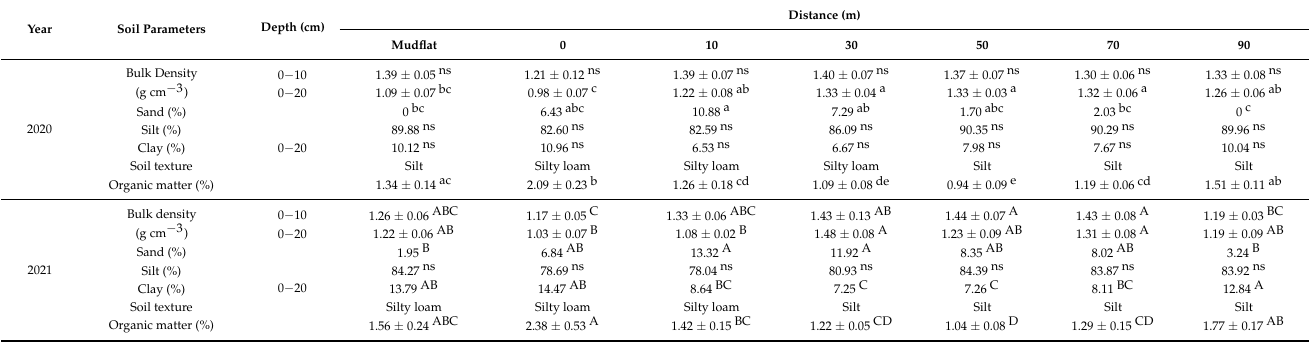
Table 2. Soil properties, including bulk density, soil particles, soil texture, and soil organic matter (mean ± SE), in the separate soil depths during October 2020 and November